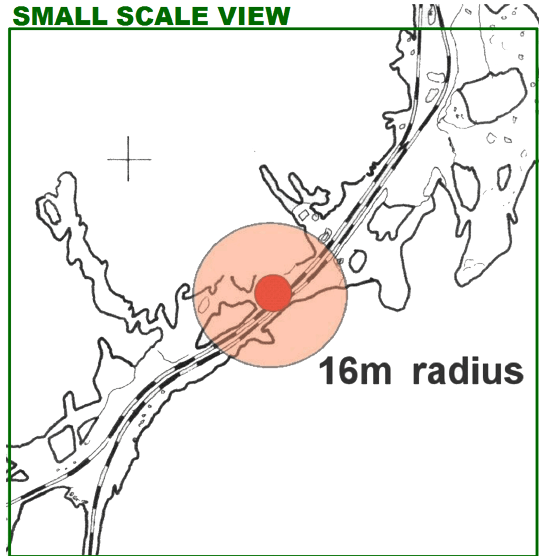
Fig. 10. Estimated radius of good-quality connection for first repe- tition along the main path of the